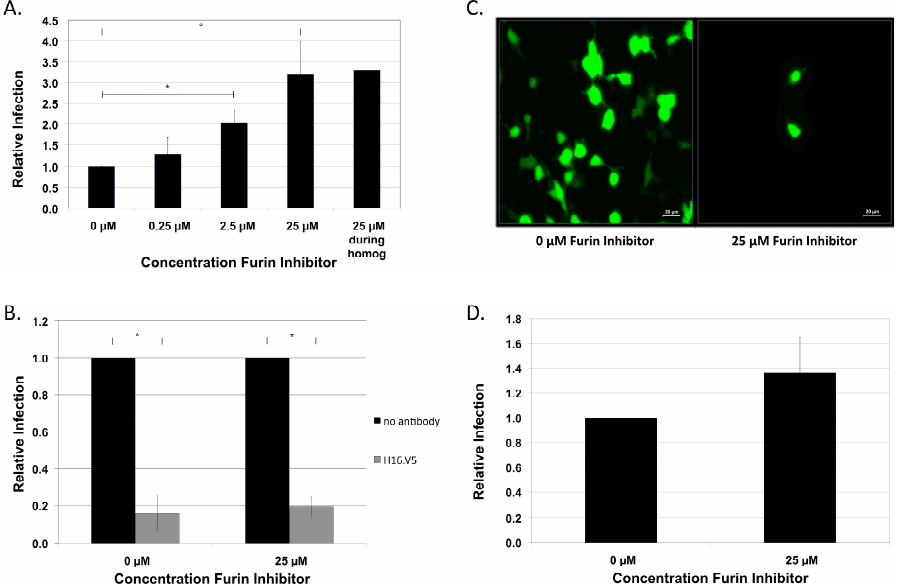
Figure 1. Furin-independent HPV16 NV infection. ( A ) Infection of HaCaT cells with foreskin-derived HPV16 at increasing concentrations (0.25 µM, 2.5 µM, 25 µM) of the furin peptide inhibitor. The infection at 25 µM inhibitor concentration was also repeated after harvesting the virus in the presence of 25 µM inhibitor; ( B ) Virus preparations were incubated with 1:100 dilutions of H16.V5 antibody for 1 h prior to infections in the absence or presence of 25 µM furin inhibitor; ( C ) HPV16 PsV and ( D ) HPV16 NV infections of 293TT cells in the absence or presence of 25 µM furin inhibitor. HPV16 PsV infection was assessed by immunofluorescent microscopy monitoring GFP-expression two days post-infection. HPV16 NV infections were analyzed by RT-qPCR measuring the relative amount of E1^E4 transcript two days post-infection. The data is plotted as relative infection at the different concentration with infection at 0 µM furin inhibitor set equal to one. The results are expressed as the means of at least three independent infections utilizing at least two different virus preps and standard deviations are shown. Statistical significance (denoted by asterisks) was determined by student’s t -test and significance was defined as p ≤ 0.05.